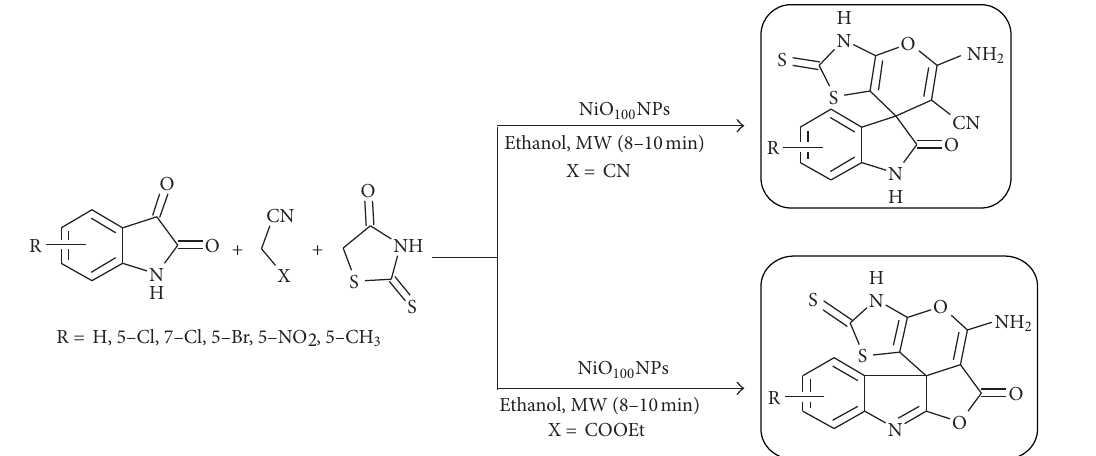
S 1: Synthesis of spiro and condensed indole